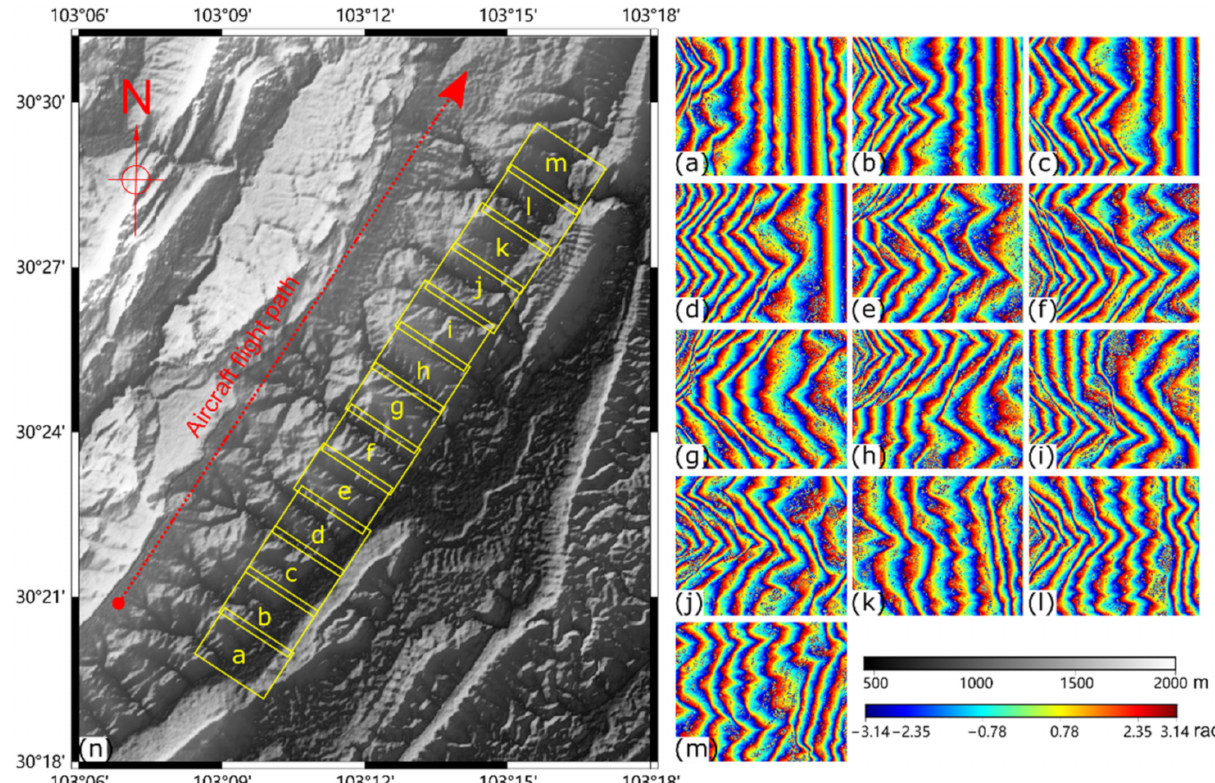
Figure 7. Scene coverage distribution of the Qionglai experiment ( n ), where a 30-m resolution DEM is taken as the base map, and filtered interferometric phase of the 13 scenes ( a – m ). However, phase filtering cannot reduce the challenge of interfering PU in rugged mountainous areas. The overlap and shadows in mountainous areas caused the interference fringes to be severely distorted, and the two-dimensional continuity was destroyed